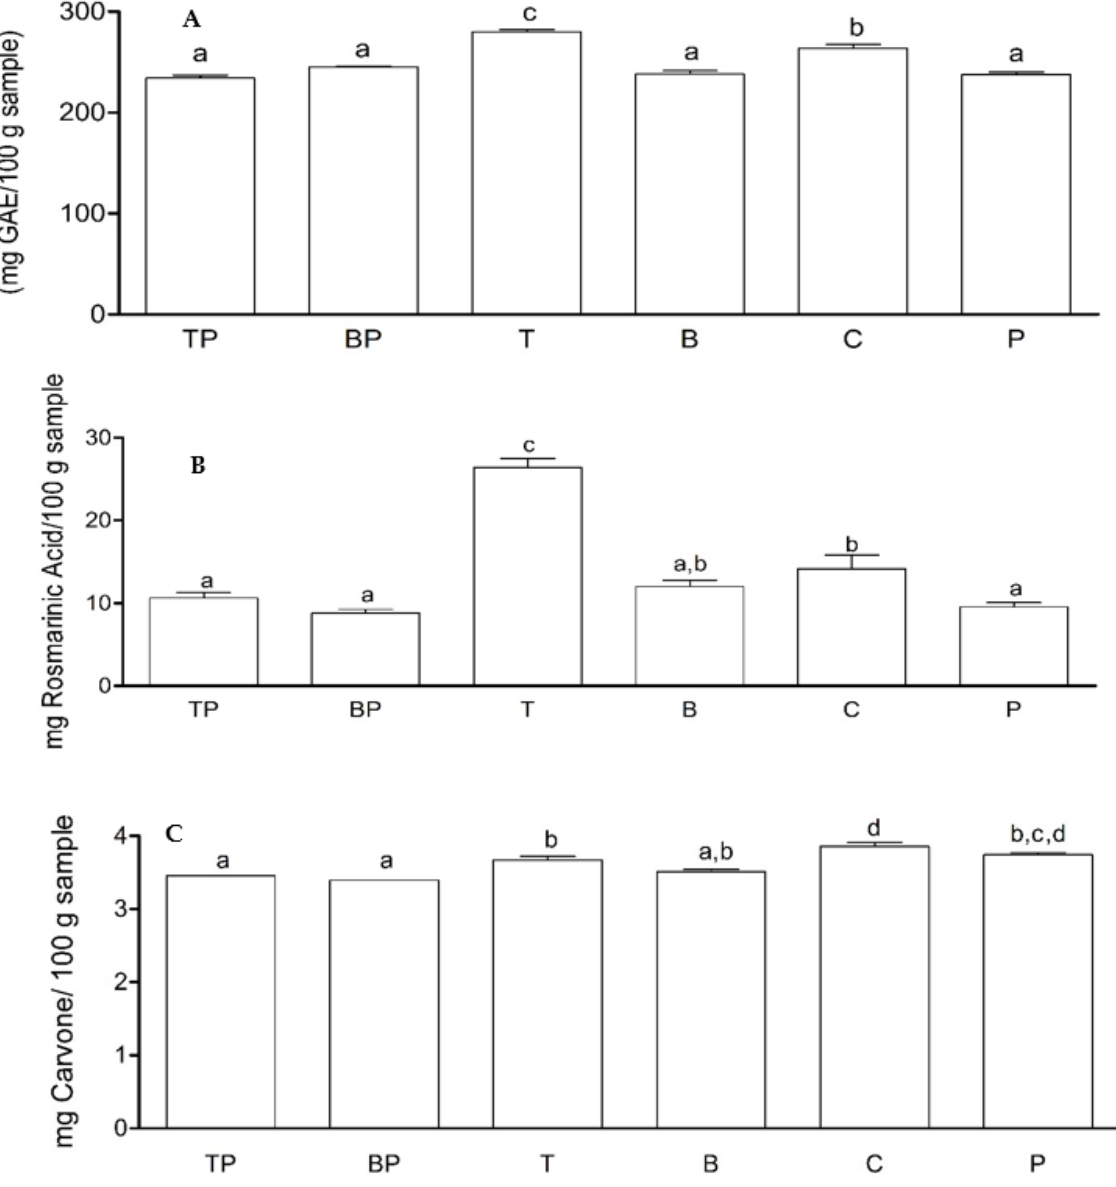
Figure 5. Contents of specialized plant metabolites in M. spicata . Rosmarinic acid content ( A ), total polyphenols ( B ), and carvone content ( C ) in samples of M. spicata . The treatments were: TP, Plants with endophyte T. asperellum + Rhizoctonia sp.; BP, Plants with endophyte B. subtilis + Rhizoctonia sp.; T, Mint plants with T. asperellum endophyte without pathogen; B. Mint plants with B. subtilis mint plants; C, mint plants without endophyte (control); P, mint plants without endophyte + Rhizoctonia sp. Treatments not sharing the same letter(s) are statistically significant at p < 0.05; Tukey HSD .